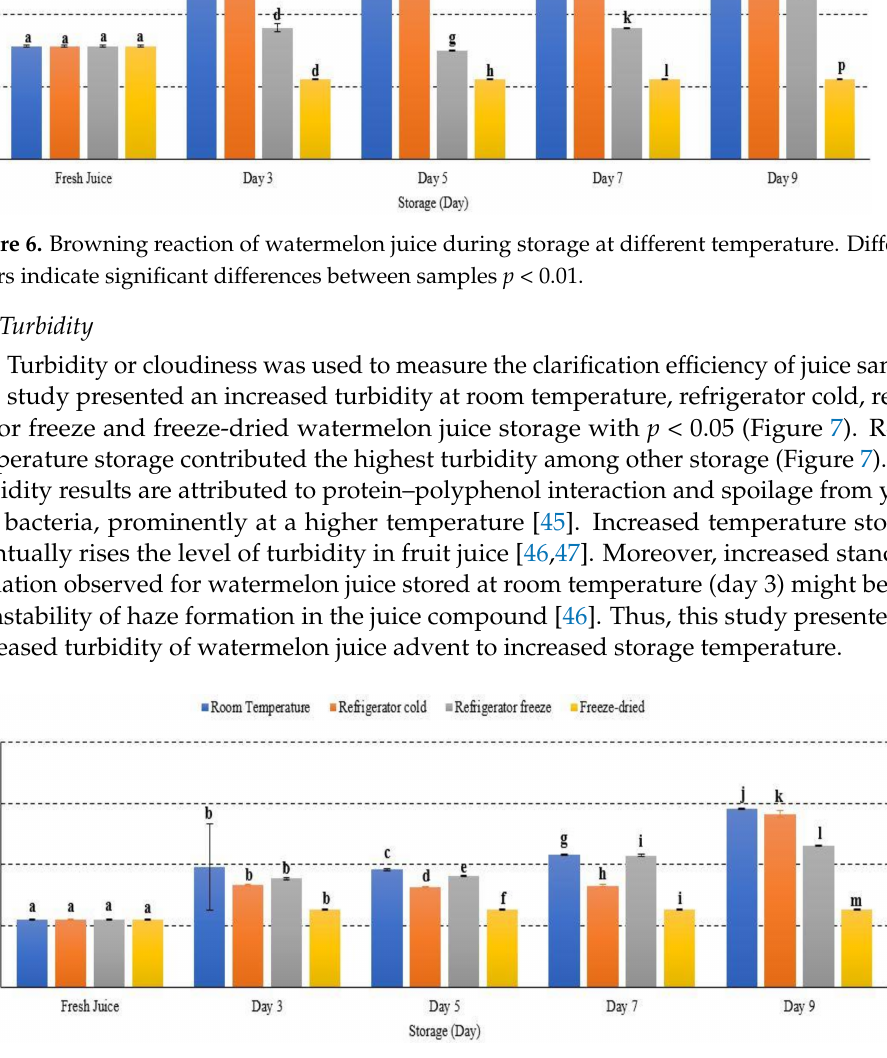
Figure 7. The absorbance turbidity of watermelon juice during storage. Different letters indicate significant differences between samples p <